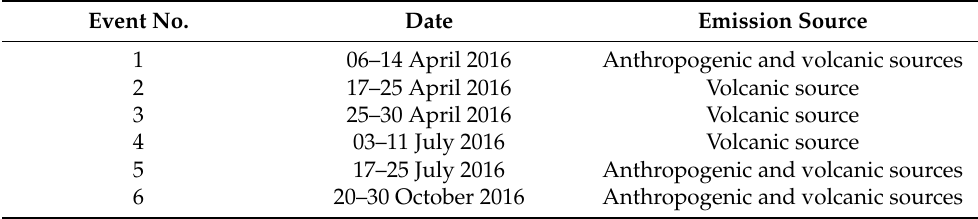
Table 1. SO 2 long-range transportation